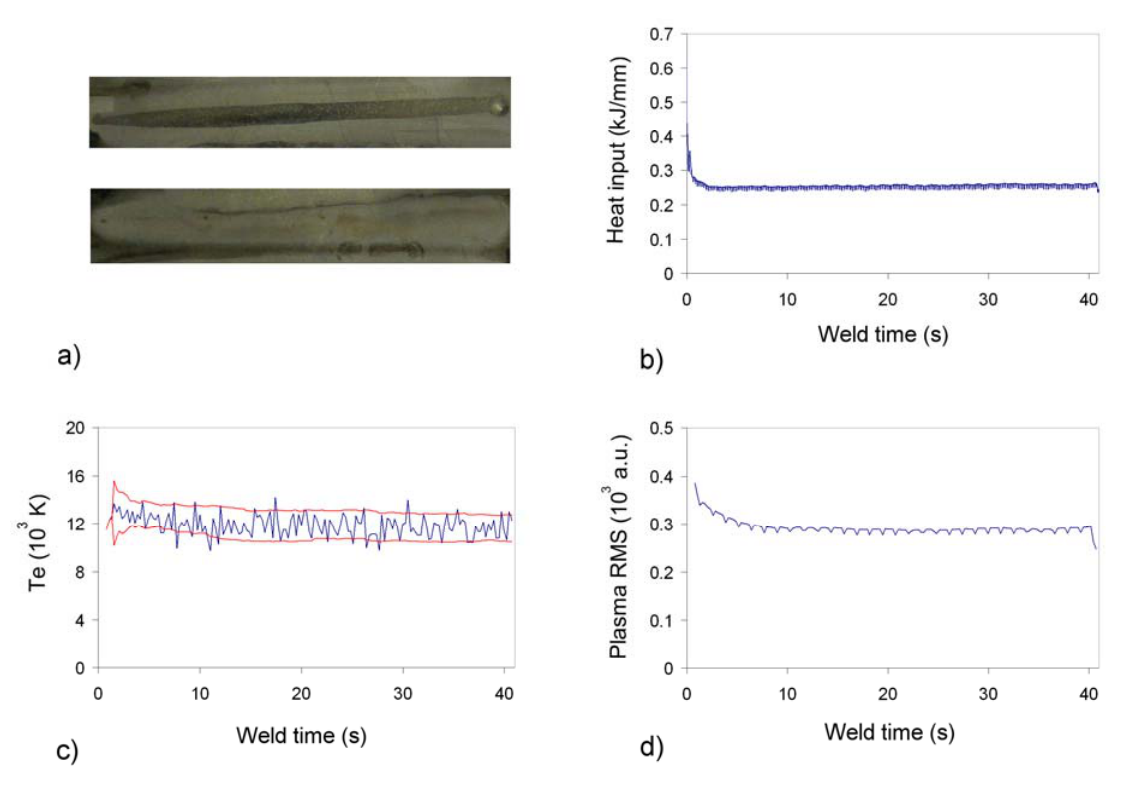
and plasma RMS profiles for defective weld (lack of penetration) Figure 6 . Heat input, T e on Titanium